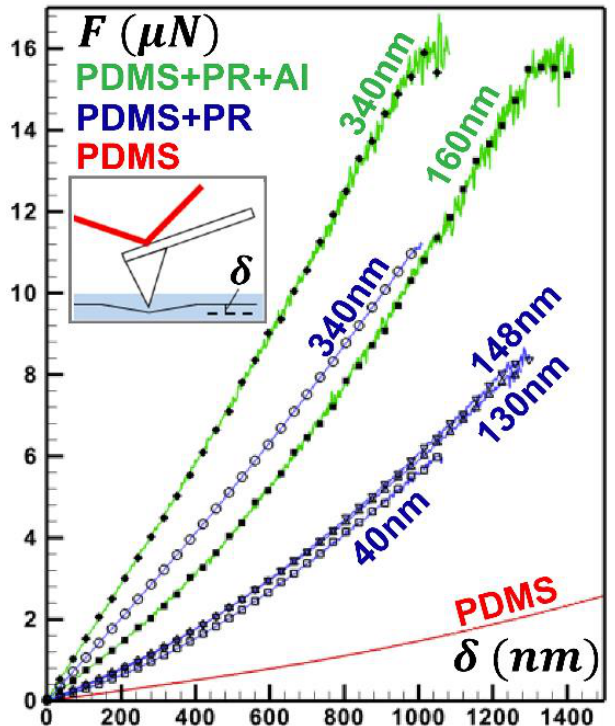
Figure 4. Force (F, µ N)-indentation ( δ ,nm) measurements by AFM on various Al-PDMS bilayers on a glass slide. F − δ curves are color-coded by sample types: Red—1.5 mm PDMS, Blue—a 1.5 mm PDMS substrate with a jammer (parylene-C) of various thickness ( t = 40,130,148, and 340 nm), Green—a 50 nm Al film over a 1.5 mm PDMS substrate with a jammer of t = 160 and 340 nm. Inset: schematics of AFM-based nano-indentation measurement.